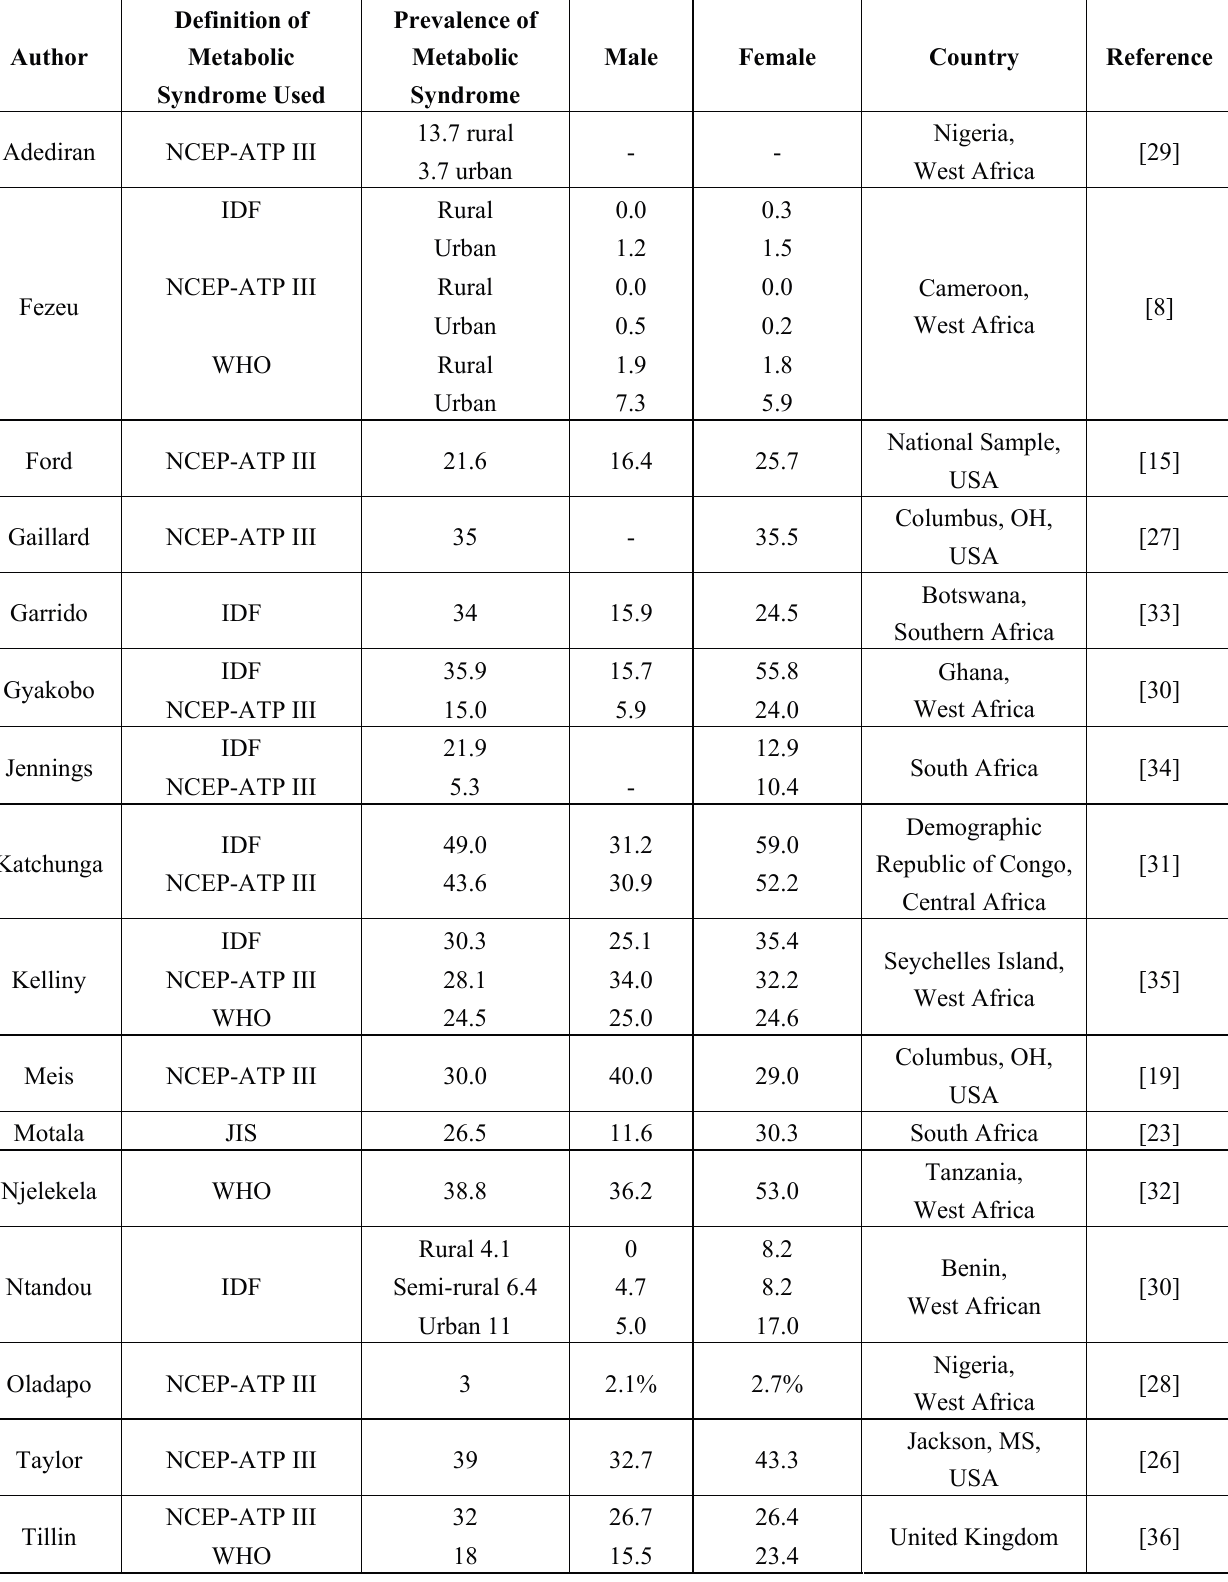
Table 2. Summary of metabolic syndrome in various populations of people of African